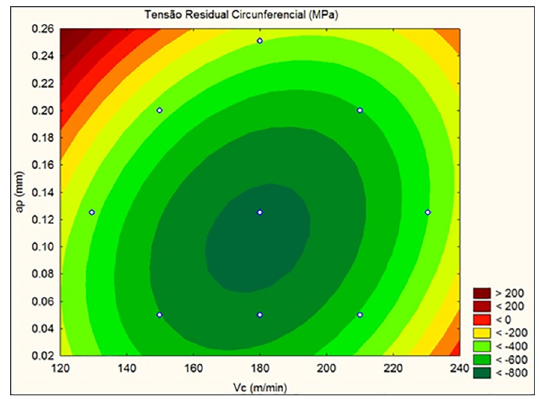
x v " plot for circumferential residual stress values Figure 2. "a p c